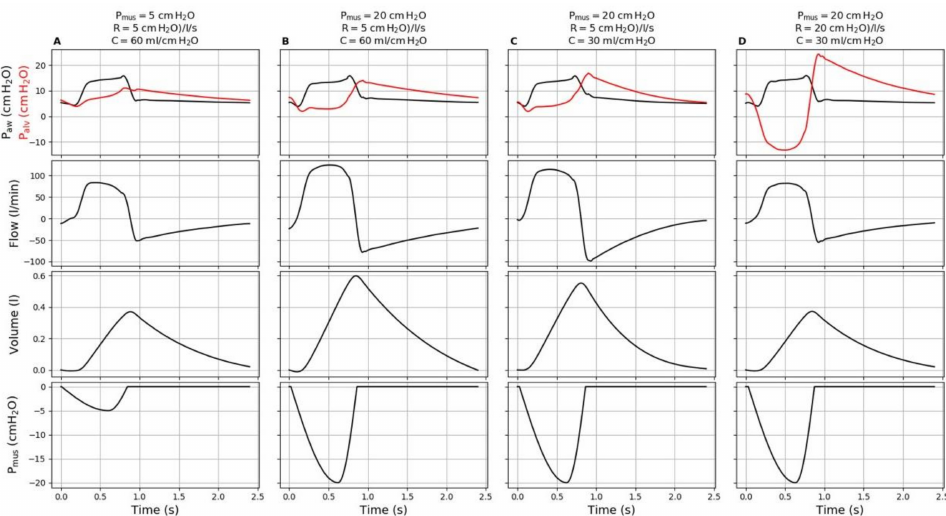
Figure 2. Combined effects of inspiratory effort and respiratory mechanics on tidal volume and alveolar pressure during pressure support ventilation. A ventilator set in pressure support ventilation with a PEEP level of 5 cm H 2 O and a pressure support level of 10 cm H 2 O was connected to an active lung simulator that simulated various respiratory system compliance (C), resistance (R) and muscle pressure (Pmus). Note that Pmus of 5 and 20 cm H 2 O correspond to esophageal pressure swings ( ∆ Pes) around 3 and 18 cm H 2 O. When simulating normal respiratory mechanics and low inspiratory effort ( A ), the tidal volume was within usual clinical range and alveolar pressure (Palv, red line) remained above the PEEP. Marked increases in inspiratory effort ( B ) resulted in important increase in tidal volume and decrease in alveolar pressure below the PEEP. Thus, the decrease in respiratory system compliance with the same strong simulated inspiratory effort ( C ) yielded a decrease in tidal volume without changing that much the alveolar pressure. Finally increasing the resistance ( D ) led to an important decrease in tidal volume and a dramatic drop in alveolar pressure far below 0 cm H 2 O. Note that of these four conditions, the one that represented the lowest risk of P-SILI (A: normal respiratory mechanics, low inspiratory effort, alveolar pressure above the PEEP) and the one that represented the highest risk of P-SILI (D: impaired respiratory mechanics, intense inspiratory effort, fall in alveolar pressure far below zero) led to similar tidal volumes and comparable flow and airway pressure waveforms. Thus, the detection of a situation at high risk of P-SILI can be particularly difficult during pressure support ventilation and may be facilitated by esophageal pressure monitoring and careful clinical assessment. Definition of abbreviations: